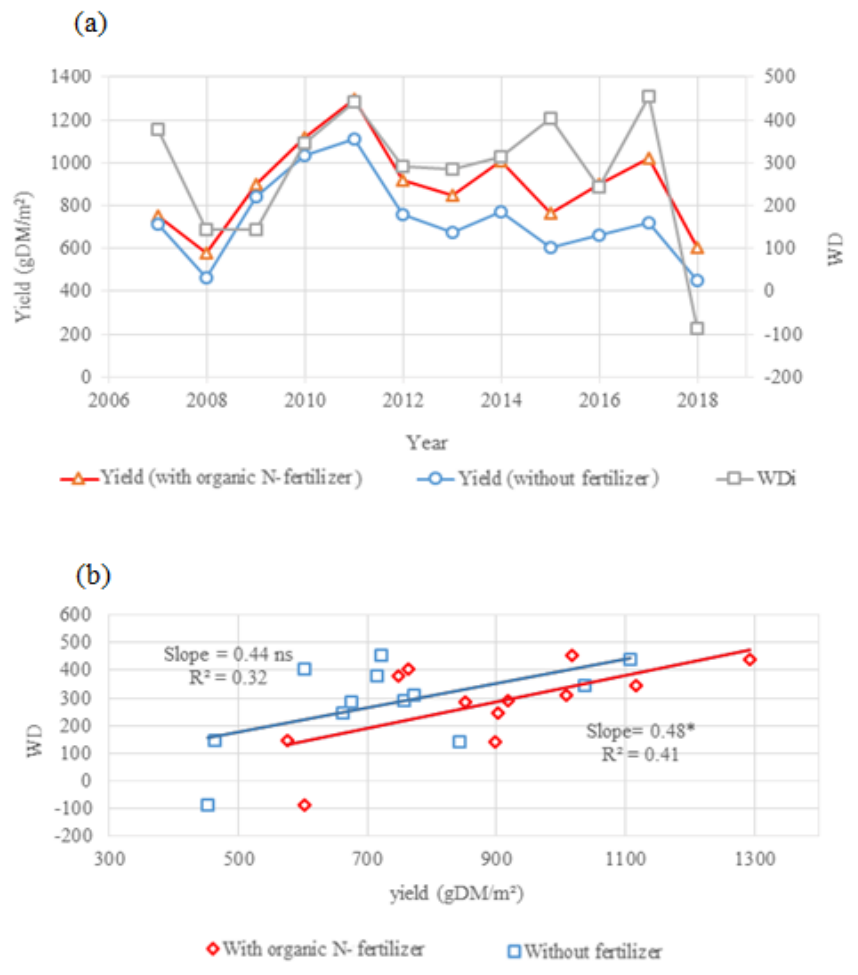
Figure 8. ( a ) Time series of herbage yield and WD for the selected time period (2007–2018). ( b ) Dry matter (DM) yield values plotted against WD index. The lines denote a regression analysis. A significant relationship (* p < 0.05) is shown between WD and herbage yield with regard to the fertilizer management. ns = not significant.